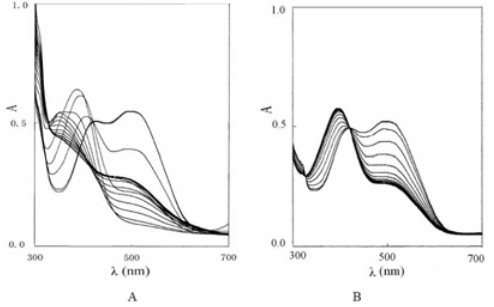
Fig. 7 Kinetic spectra of the LiP catalyzed oxidation of PR in the presence (A) or absence (B) of VA. Conditions: The LiP (0.1 μ M) catalyzed oxidation of PR (40 μ M) in the presence (A) or absence (B) of VA (10 mM) was initiated by H 2 O 2 supplied enzymatically ([GOD] = 0.3 μ g · mL − 1 , [glucose] = 0.1 mM). The time interval for scanning was 10